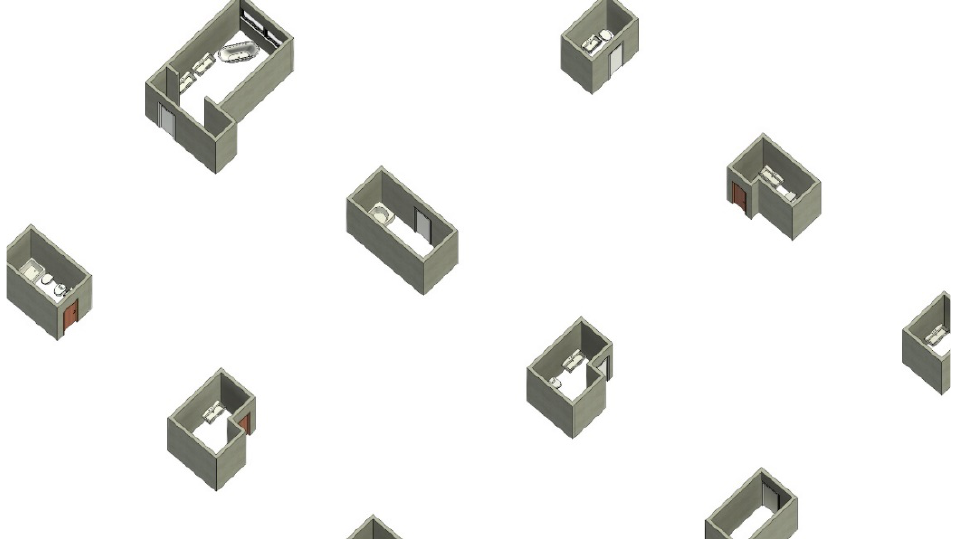
Figure 6. Sample 3D view of the generated modules.